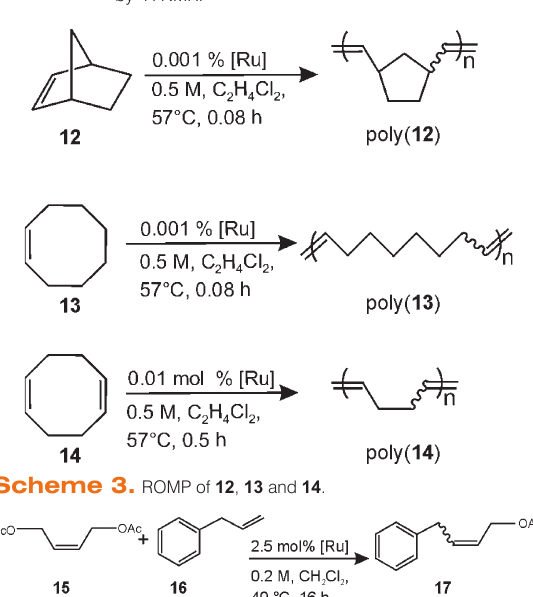
loading, conducted in C by 1 H NMR.